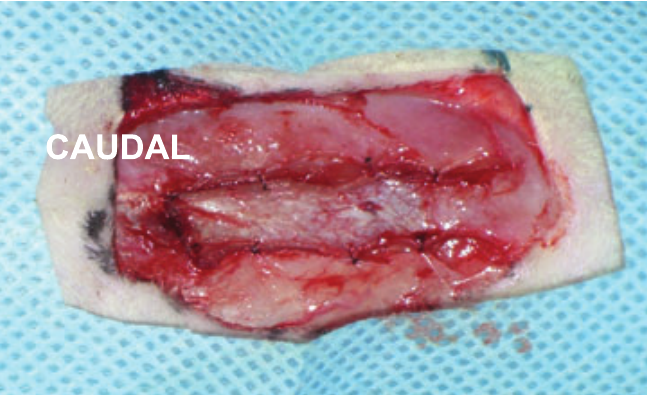
FIGURE 5 – Group E- anterior abdominal wall of rat displaying caudal devascularization of the right rectus abdominis muscle, sutured in its bed after the muscle was reflected in the caudocranial